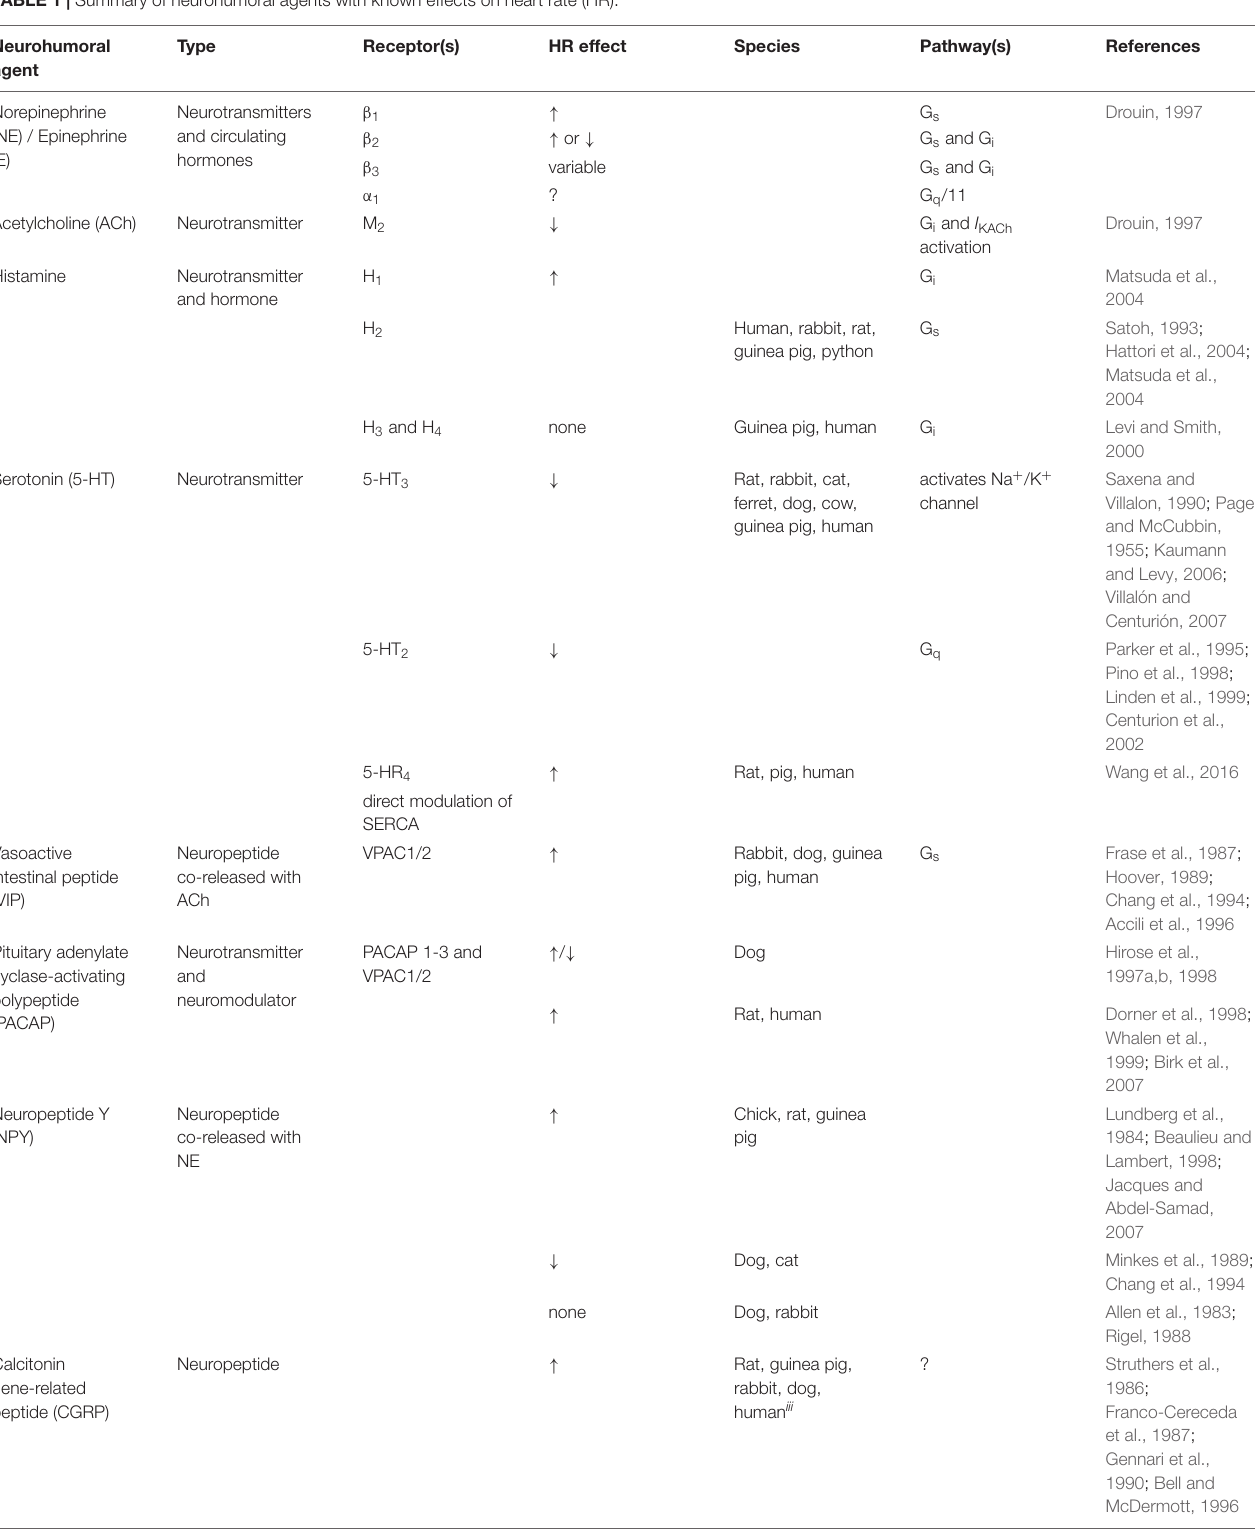
TABLE 1 | Summary of neurohumoral agents with known effects on heart rate (HR). Neurohumoral